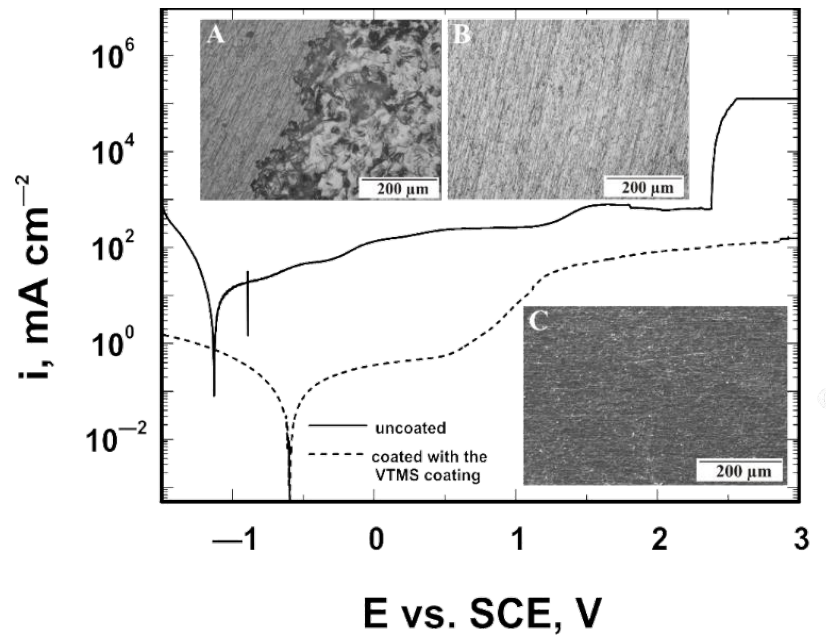
Figure 6. Potentiodynamic polarization curves analyzed in 1 mol dm − 3 NaBr solution for Ti Gr 2 with the microstructure of the uncoated substrate ( A ) and substrate after removing the VTMS coating ( B , C ) after corrosion tests. A and B were taken with the GX41 Olympus optical microscope, whereas C was taken with a JEOL JSM- 6610 LV scanning electron